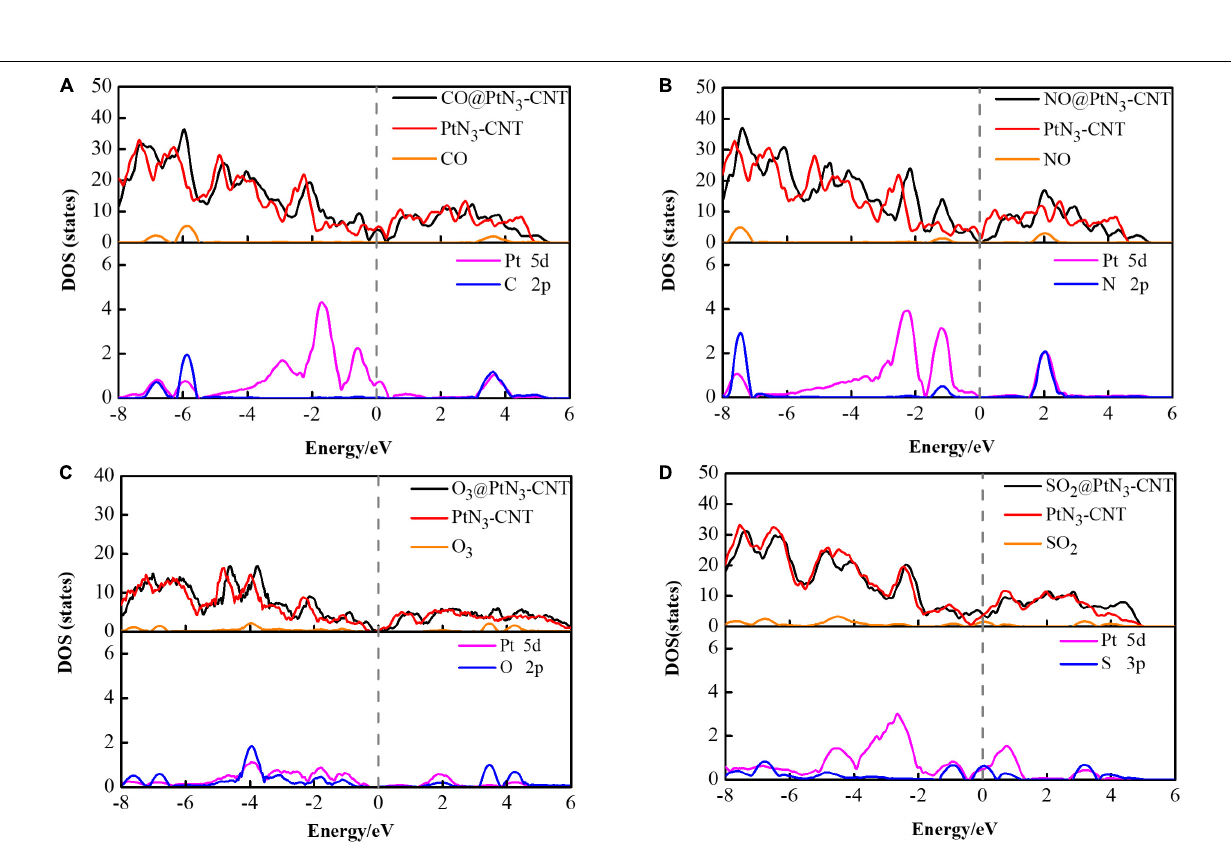
Frontiers in Ecology and Evolution |